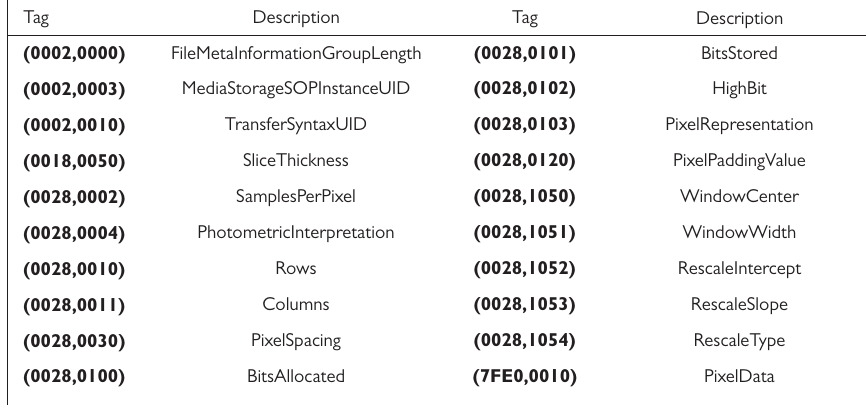
Table 2. Non-removed Digital Imaging and Communications in Medicine Tags During Anonymization Are Shown